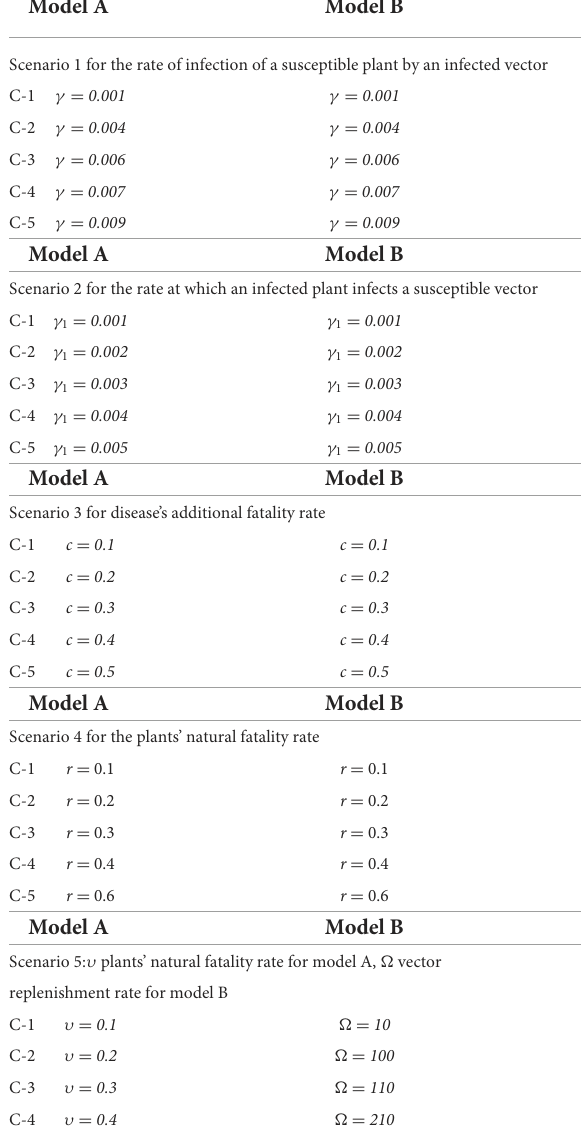
TABLE 2 Scenarios for model A and model B of non-linear